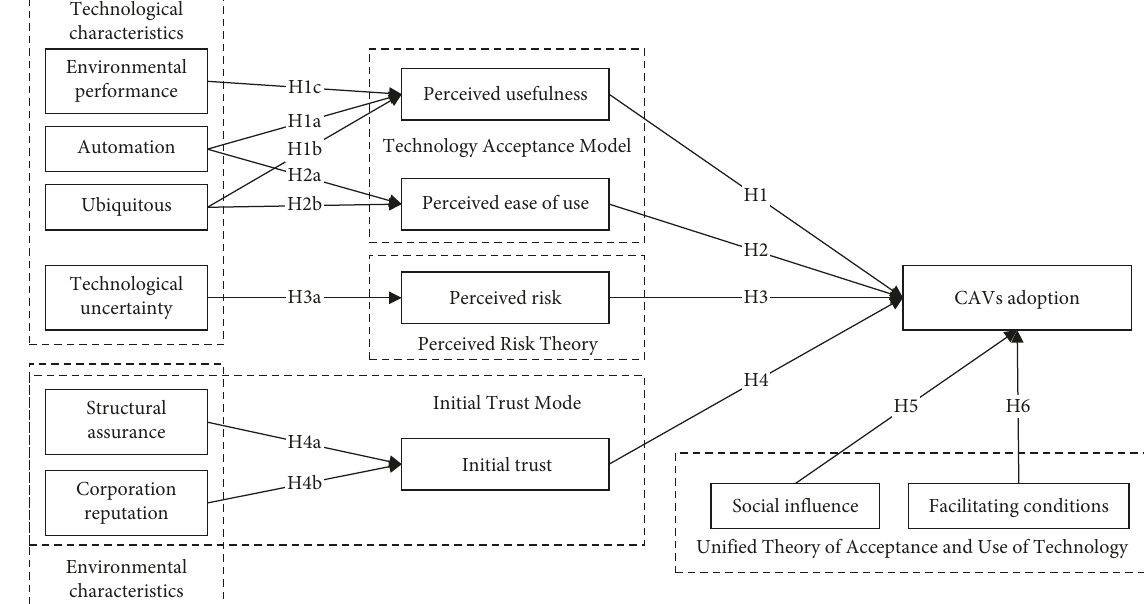
Figure 1: The research